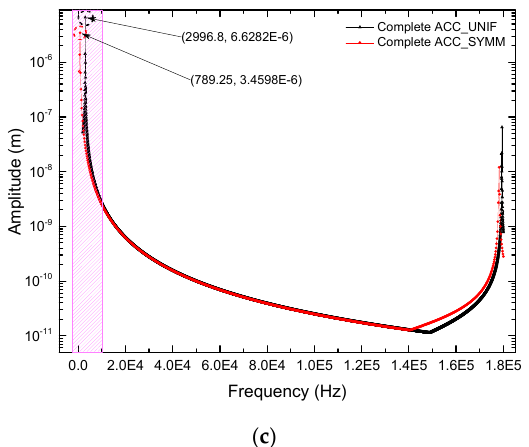
Figure 5. Harmonic response of devices: ( a ) 1 / 4 of ACC_UNIF and 1 / 4 of ACC_SYMM, ( b ) 1 / 2 of ACC_UNIF and 1 / 2 of ACC_SYMM and ( c ) Complete ACC_UNIF and Complete of ACC_SYMM.